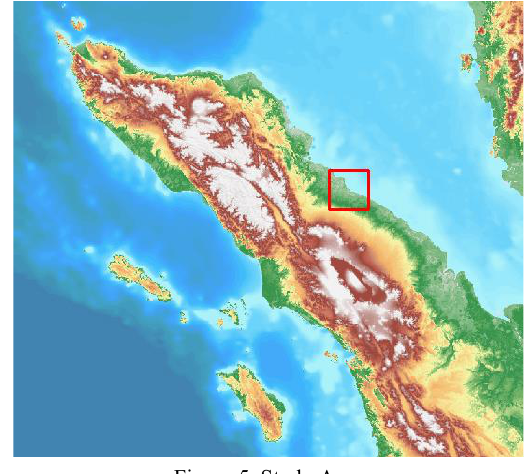
Figure 5. Study Area